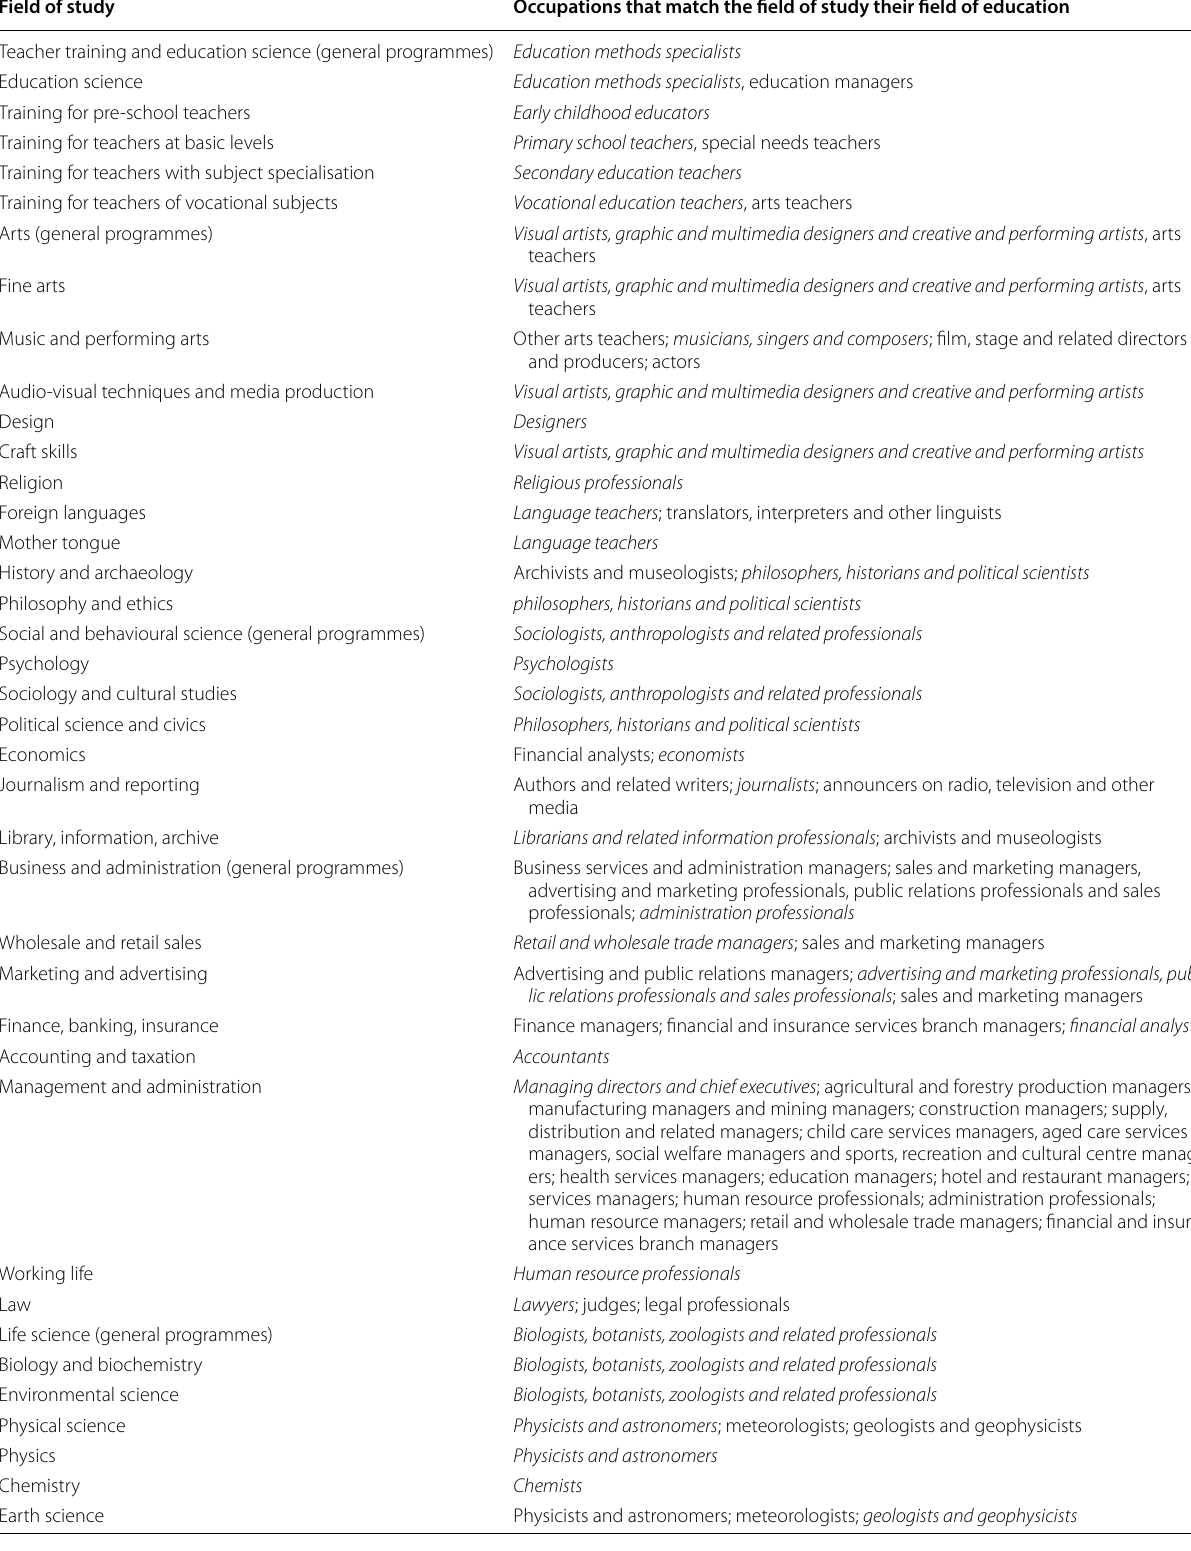
Table 6 The field of study-occupation matches Field of